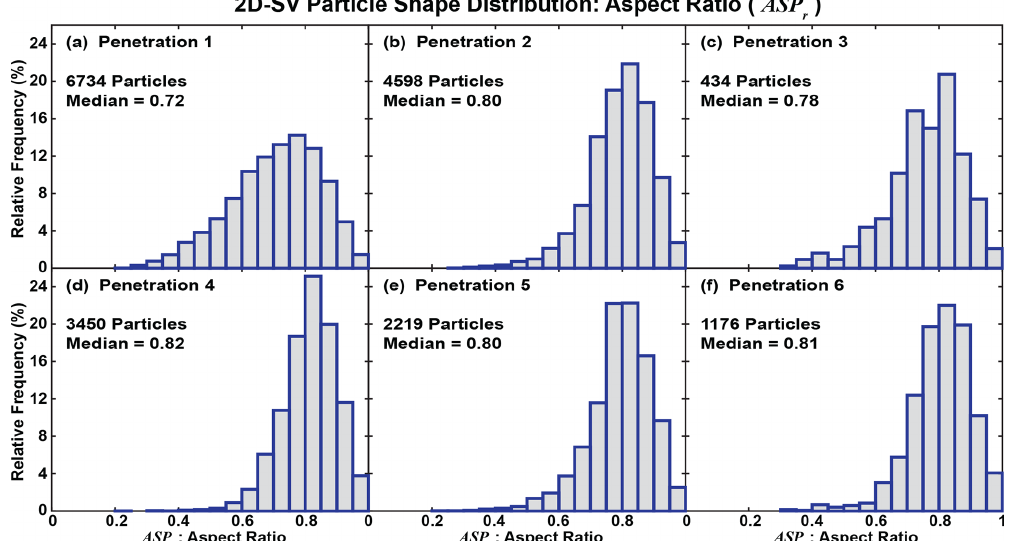
Figure 8. Histograms of 2D-SV particle aspect ratio (ASP r ) for (a–f) penetrations 1–6 (Fig. 1d, Table 2). Number of particles and distribution median indicated for each penetration.